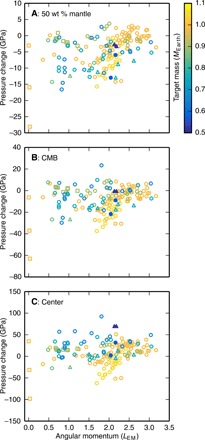
Contrary to expectations, the pressures in bodies after giant impacts are often lower than those in the larger of the pre-impact bodies.Symbols show the pressure differences between the pre-impact target and post-impact body for the impacts in Fig. 2 (A to C). The pressures in the target bodies were calculated using HERCULES, assuming that the body was a magma ocean planet. Panels show the pressure difference at the middle of the mantle by mass (A), at the CMB (B), and at the center (C) of bodies as a function of the AM of the post-impact bound mass. Colors indicate the mass of the target body, and symbols are the same as in Fig. 2. Filled symbols are discussed in the main text.